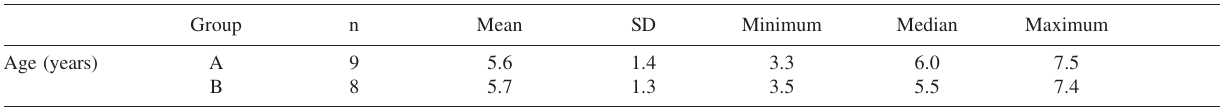
Table 2 - Descriptive statistics for age (years) of patients per group on admission Group